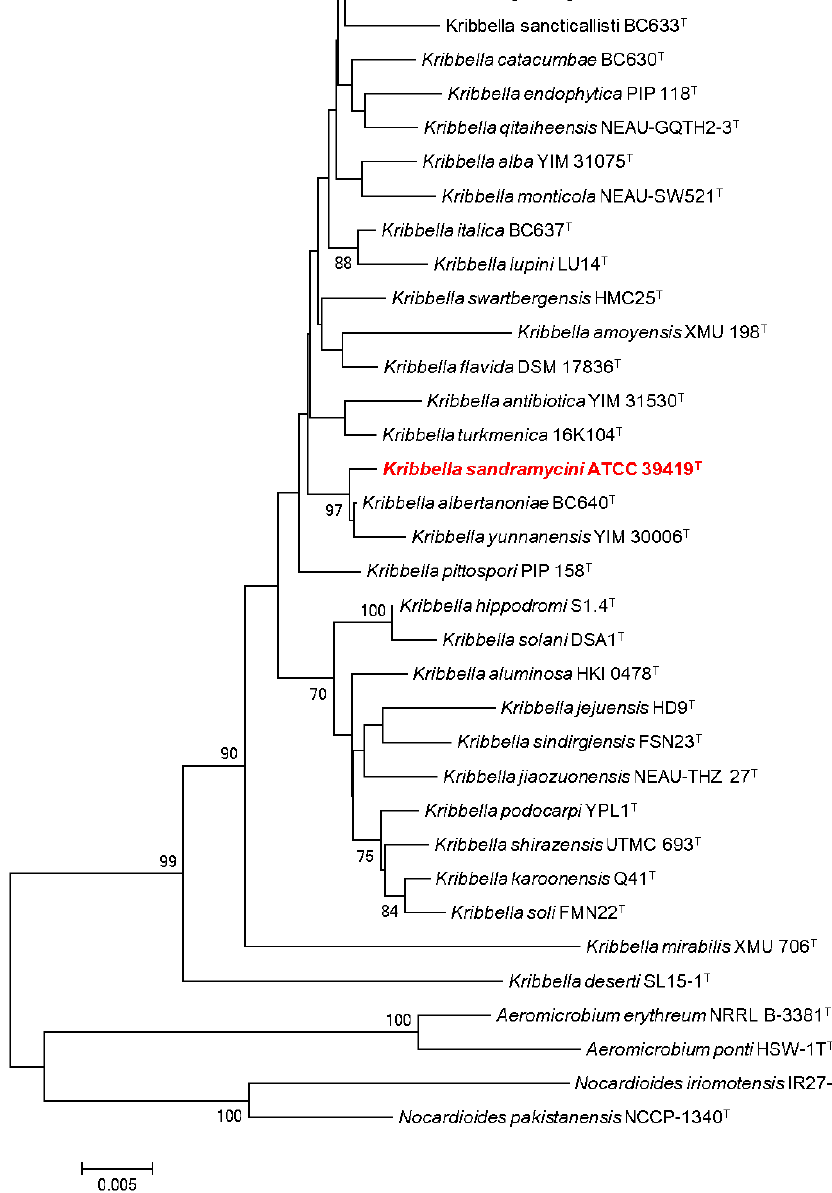
Figure 1. Phylogenetic tree based on the 16S rRNA partial gene sequences ( ≈ 1351 nt) illustrating the position of the strain CA-293567 among recognized species of the genus Kribbella and other related taxa. Determined by neighbor-joining method (Jukes and Cantor evolutive model) using MEGA (6.06 version) software. The numbers above the branches indicate the bootstrap values.